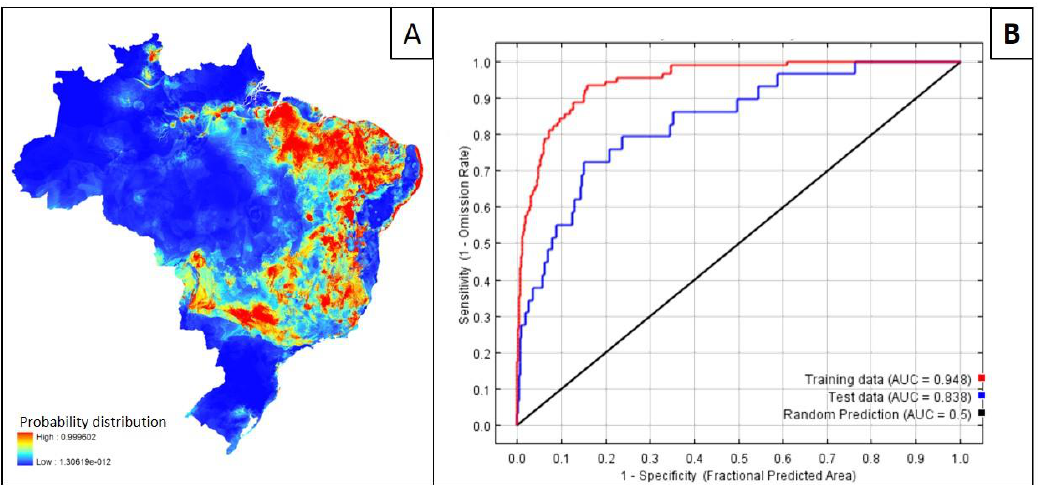
Figure 1. ( A ) Maxent-generated ecological niche model for predicting suitability for visceral leishmaniasis in Brazil based on the national surveillance program incidence data and Bioclim variables. ( B ) The accuracy of the model (0.838) was evaluated using Maxent by the area under the curve (AUC) of the receiver operating characteristic (ROC).